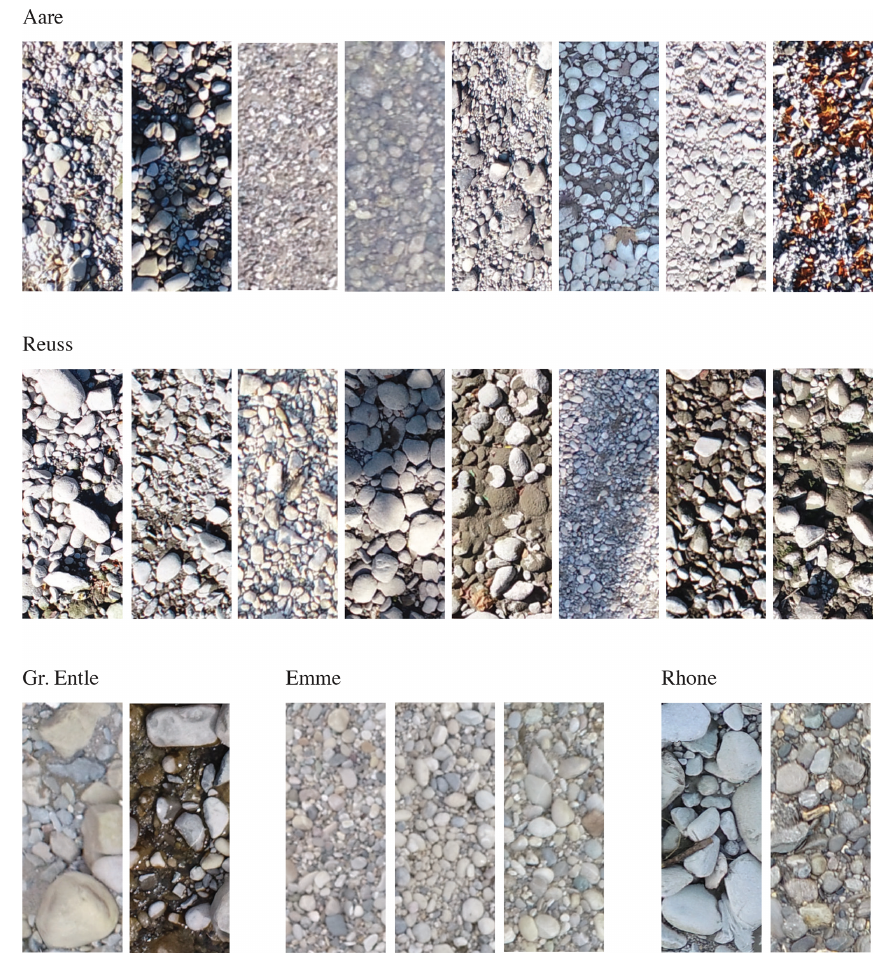
Figure F1. Tiles grouped by river name. The examples illustrate the variability between different bars along the same